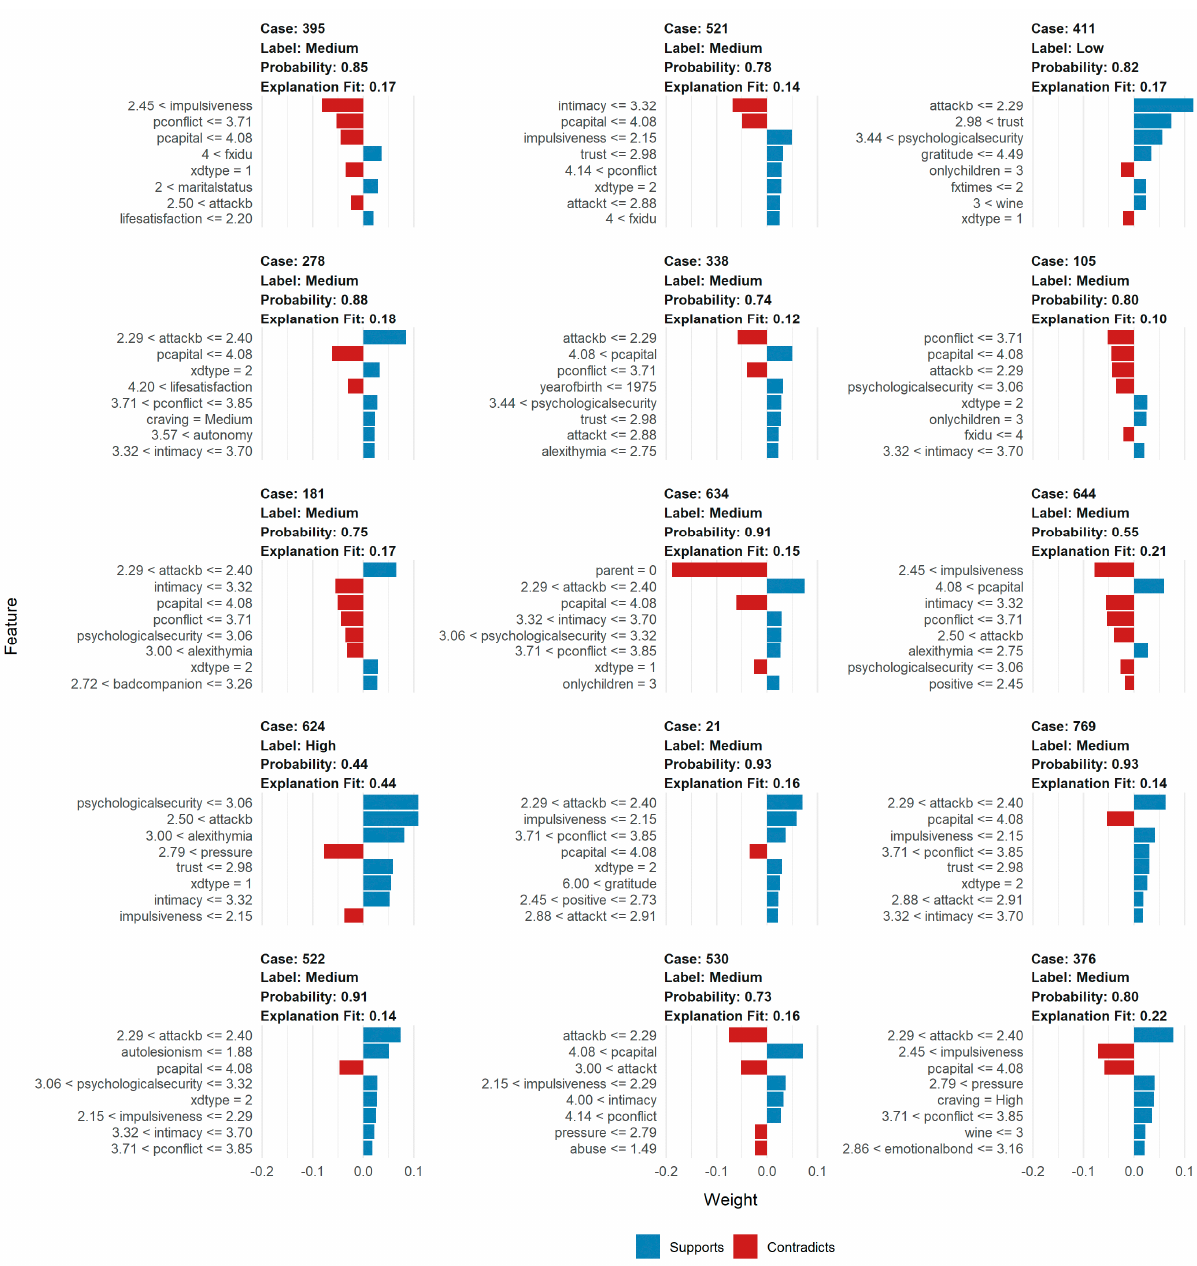
Figure 2. Correlations between factors and substance